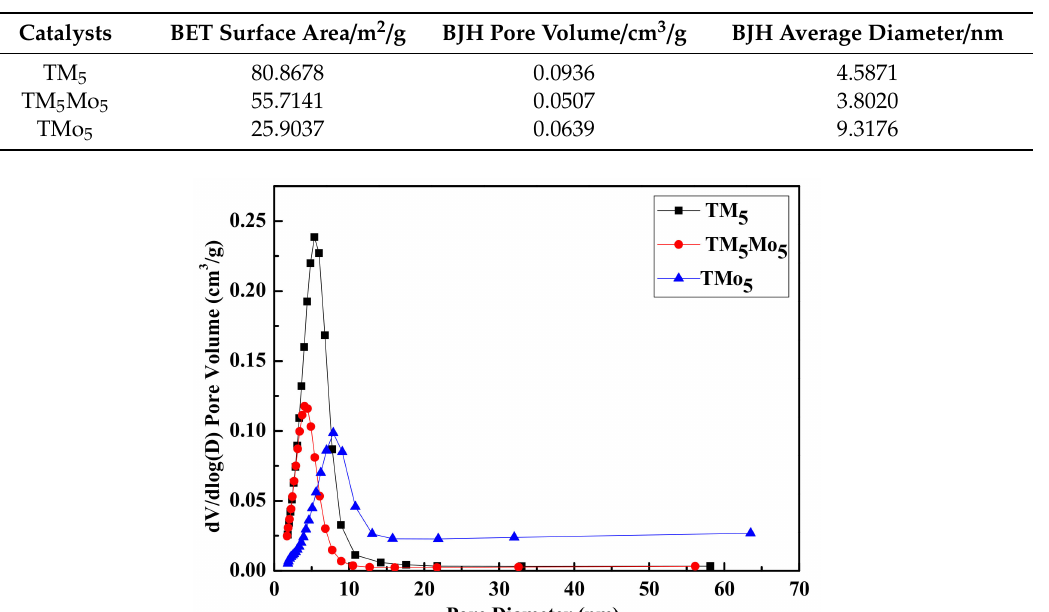
Table 1. The BET surface area of the three catalysts.